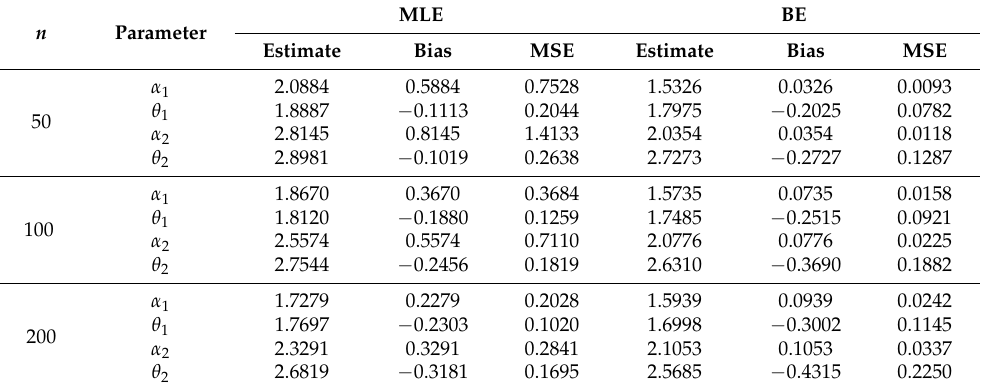
Table 3. Point estimates of ( α t , θ t ) , t = 1,2 under Scheme 3.